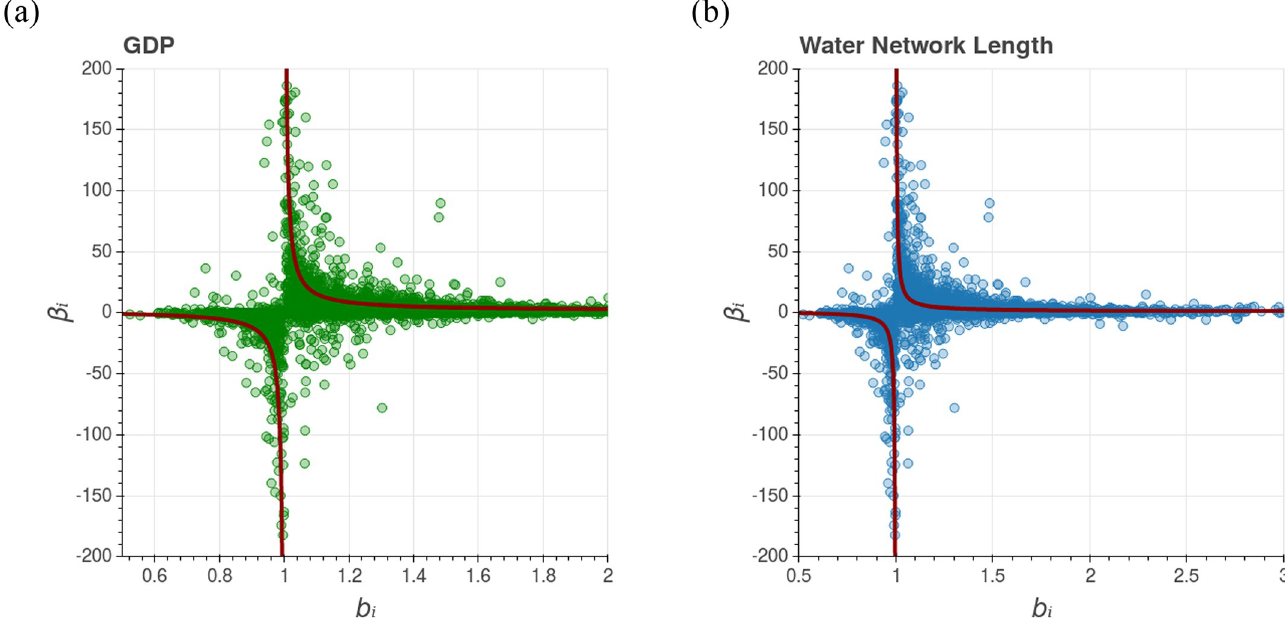
Fig 6. Graph of β as a function of the population growth rate b . GDP (on the left) and water network length (on the right). Each dot represents the data of a i i single Brazilian city and the red curve is the theoretical prediction given by Eq (10) using: � = 0 for both cases; β T = 1.15 for GDP; and β T = 0.9 for water network length. This result illustrates the strong dependence between the longitudinal scaling exponent and the population growth rate of the city. It also suggests that cities with bigger β i are the ones with little or no growth ( b i � 1). Moreover, b i < 1 (decreasing population) implies a negative β i .